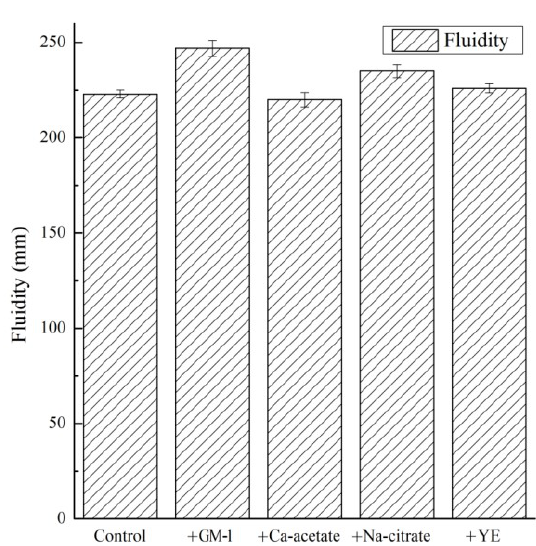
Figure 2. Fluidity of cement mortars.